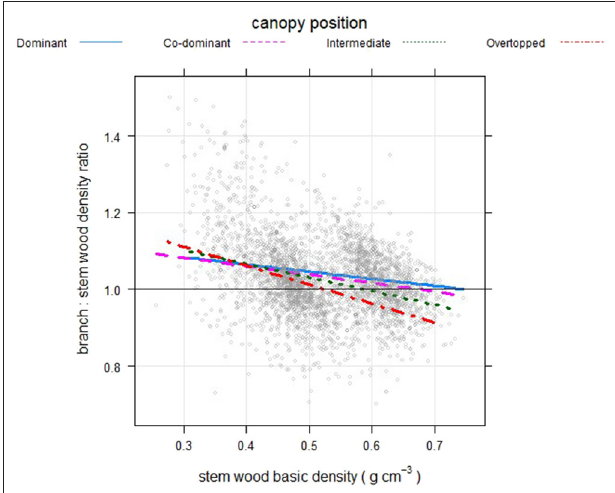
FIGURE 6 | Branch wood: stem wood basic density ratios as a function of tree stem density for North American trees (gray circles) for trees in different positions within the forest